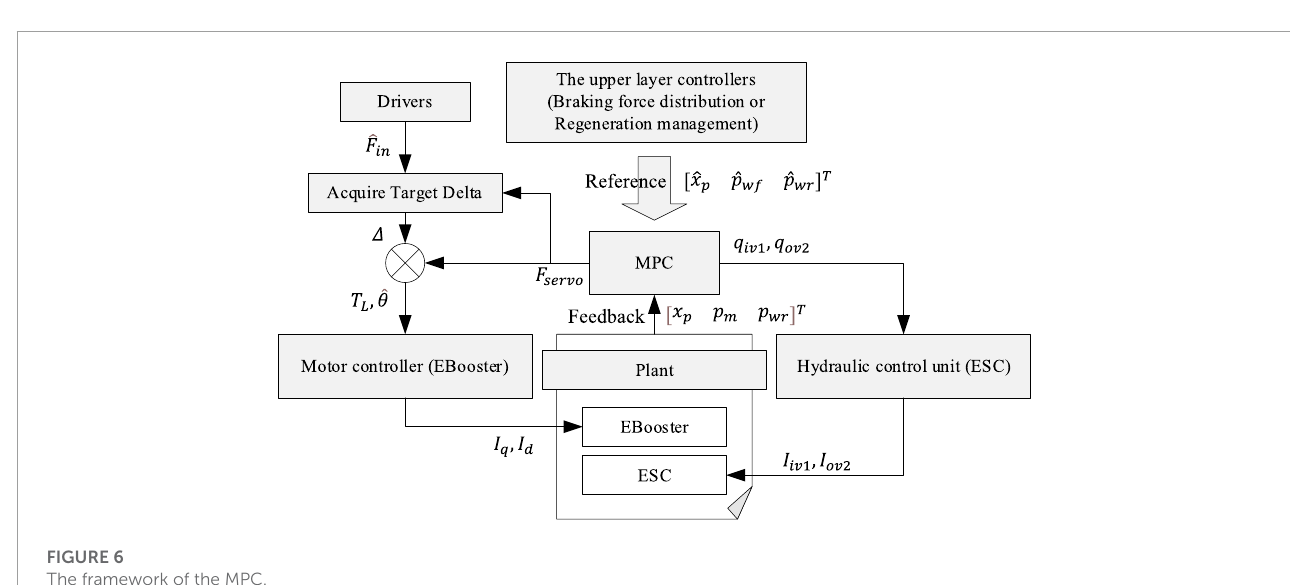
FIGURE 6 The framework of the